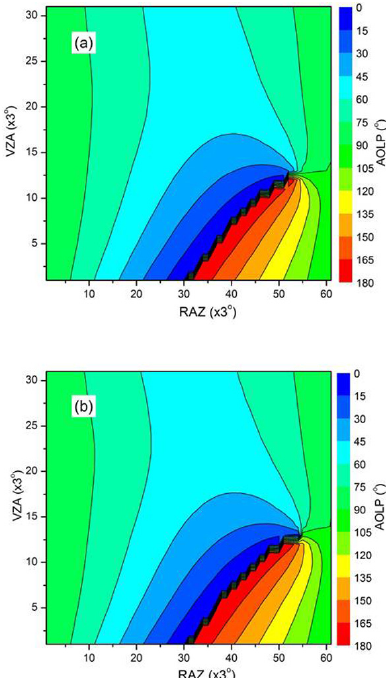
Fig. 19. Same as in Fig. 18, but for the AOLPs of the ocean– atmosphere system (a) without aerosols and (b) with sea salt aerosols,